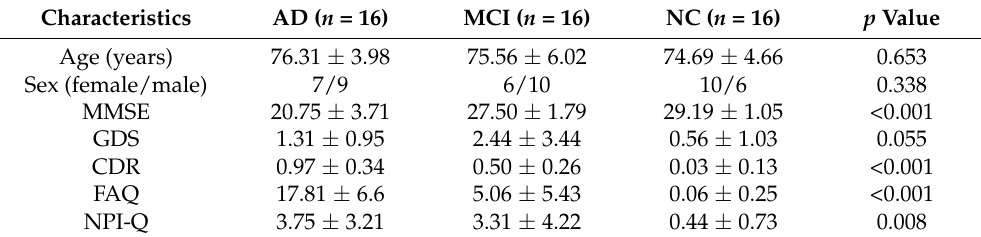
Table 1. Demographic and clinical characteristics of the participants.